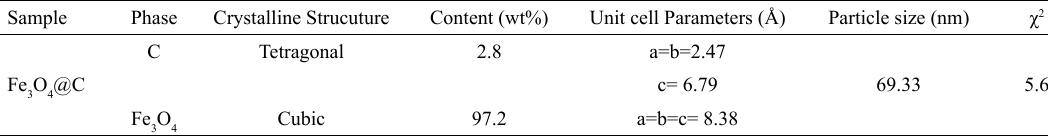
O @C nanoparticles. 3 4